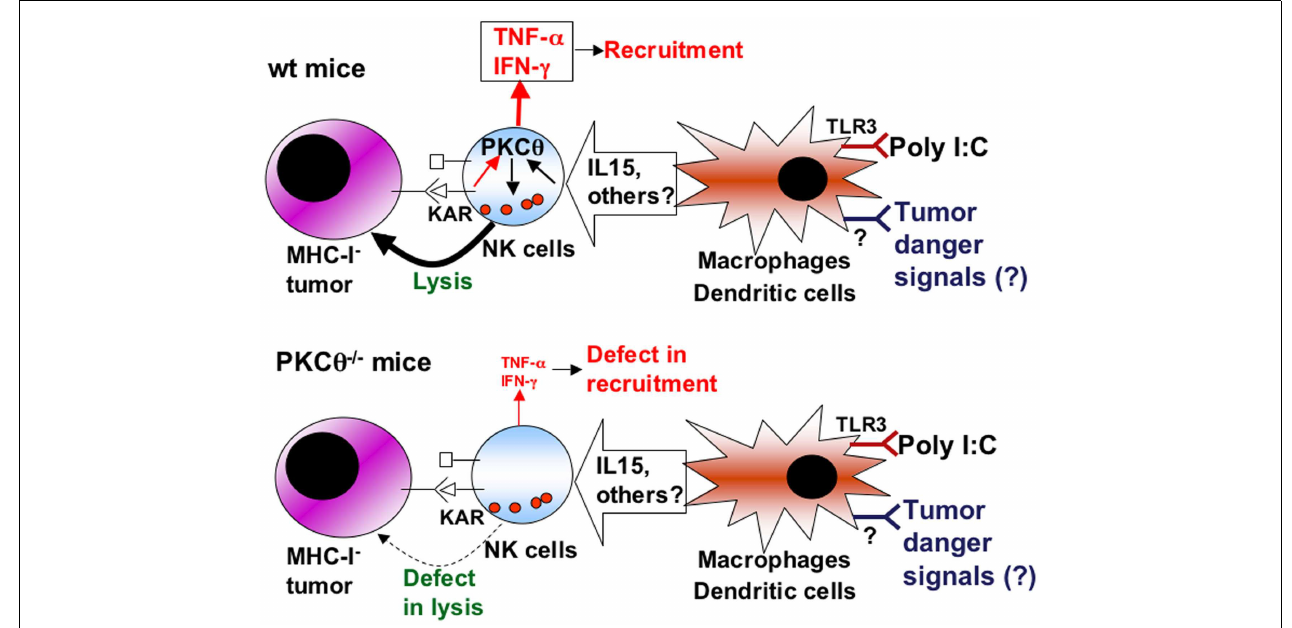
TNF- α and IFN- γ by NK cells induced by certain killer-activating receptors (KAR) is also dependent on PKC- θ (red arrows), allowing the recruitment of more immune cells and sustaining immune activation. Lower panel, situation in NK cells from PKC- θ − / − mice: as a consequence of the absence of PKC- θ , cytokines produced by macrophages and/or dendritic cells do not activate properly NK cells, which then show a defect in lysis of tumoral cells, allowing tumoral development. In addition, the production ofTNF- α and IFN- γ by NK cells is decreased, causing defects in